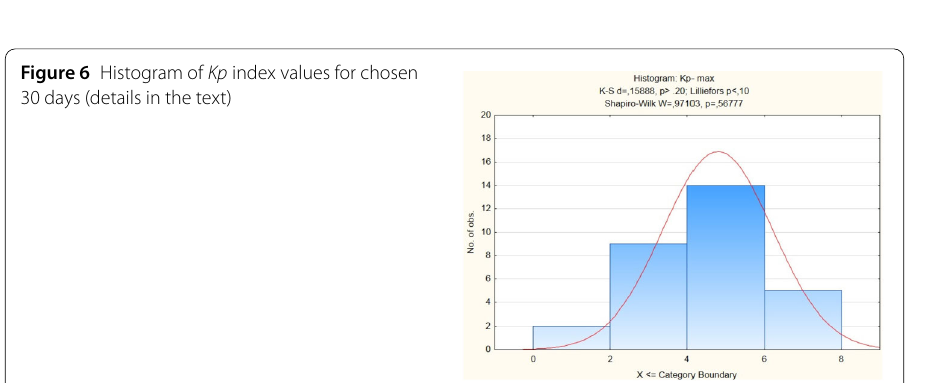
Figure 5 The superposed averaged numbers for electrical grids failures (EGFs) caused by the aging (Ag): ( c ), ( d ); electronic devices breakdowns (Ed): f; unidentified reasons (Un): ( a ), ( b ), ( e ), with a key time connected to Halo CME occurrence ( a ), ( b ), ( f ), growth of Kp index up to at least 5 ( c ), ( d ) and sudden storm commencement ( e ) in 2010 ( a ), ( c ), ( e ) and in January–July 2014 ( b ), ( d ), ( f )